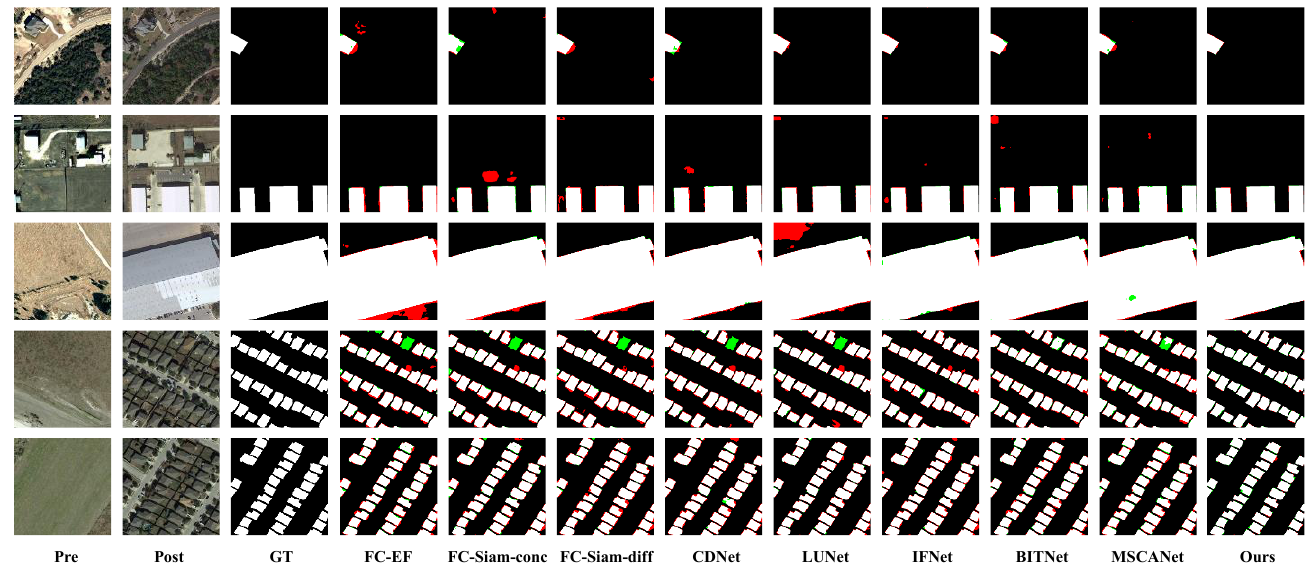
Figure 7. Visualization results of different CD methods in five scenarios from the LEVIR-CD dataset. We plot the FP in red and the FN in green in order to better compare the CD results.